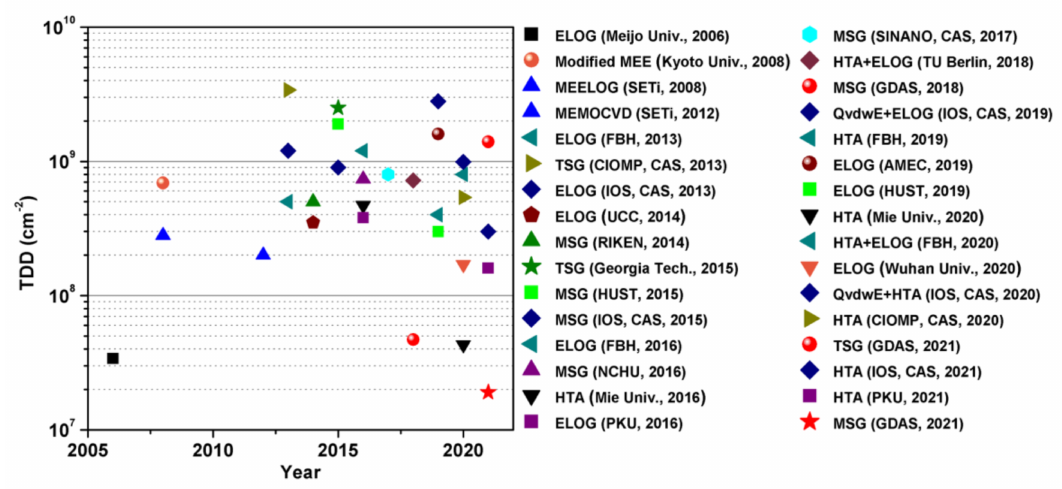
Figure 23. Selected AlN/sapphire TDD by year of publication [17,36,40,42,43,46,53,56,58–60,62,69, 73,74,76,79,81,94,98–109]. The ultralow TDD value of 3.4 × 10 7 cm − 2 has been achieved by ELOG growth technique in 2006. Since 2018, MSG and HTA growth techniques have also achieved ultralow TDD values below 5 × 10 7 cm − 2